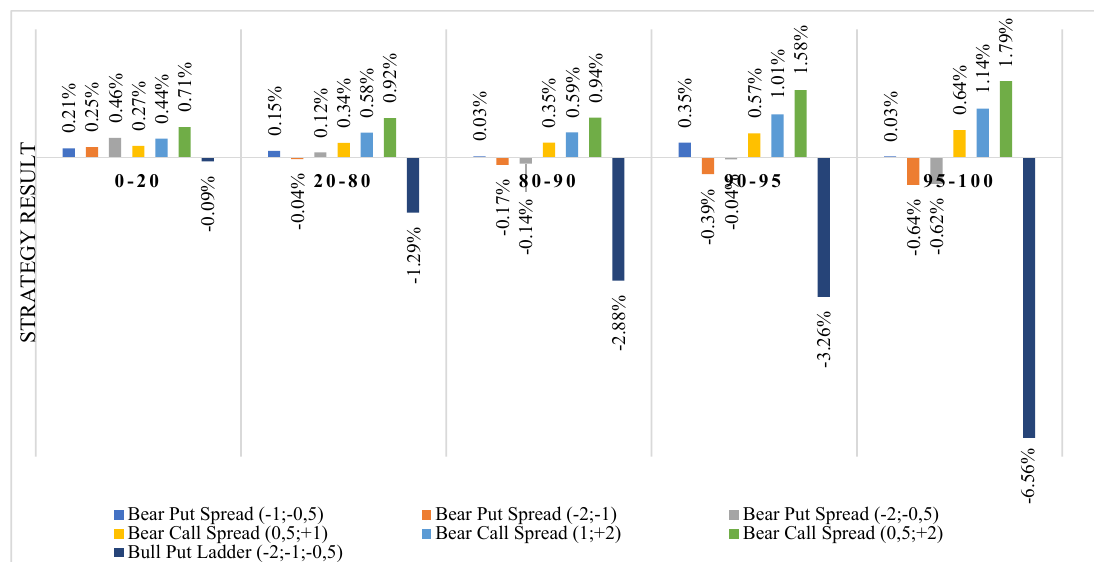
Figure 8. Bear put spread, bear call spread, and bull put ladder results for declines of WTI crude oil prices ranging from 5% to 10%.